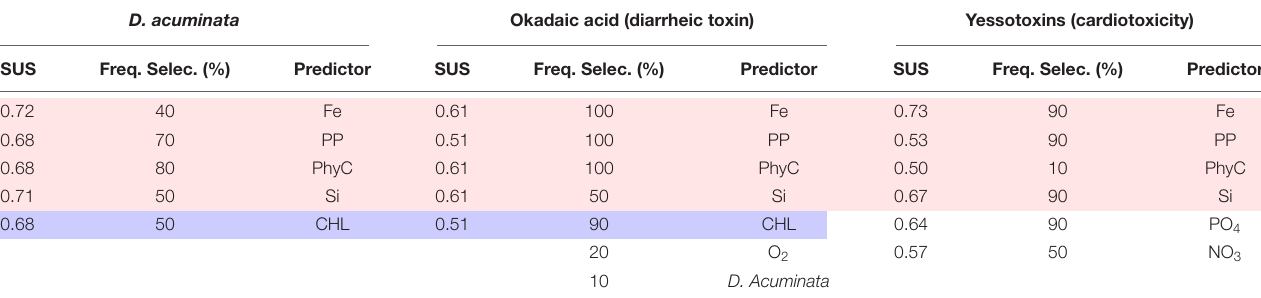
TABLE 6 | Selection of potential predictors using cross-validation showing the percentage of times that each predictor has been selected (Freq. Selec.). D. acuminata Okadaic acid (diarrheic toxin) Yessotoxins (cardiotoxicity) SUS Freq. Selec. (%) Predictor SUS Freq. Selec. (%) Predictor SUS Freq. Selec. (%)